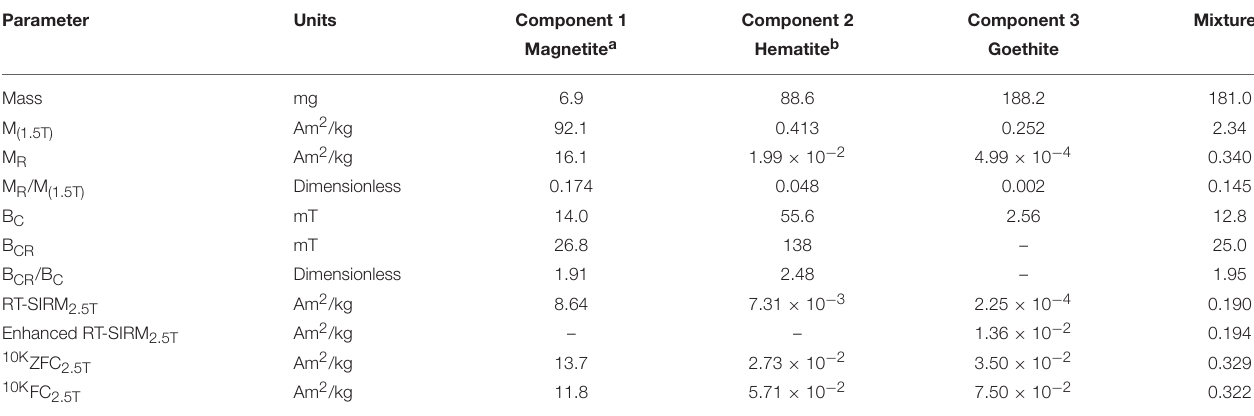
TABLE 1 | Uncorrected hysteresis and low temperature magnetic properties of the individual components and of the three-component mixture used to validate the new method and shown in Figure 2 . Parameter